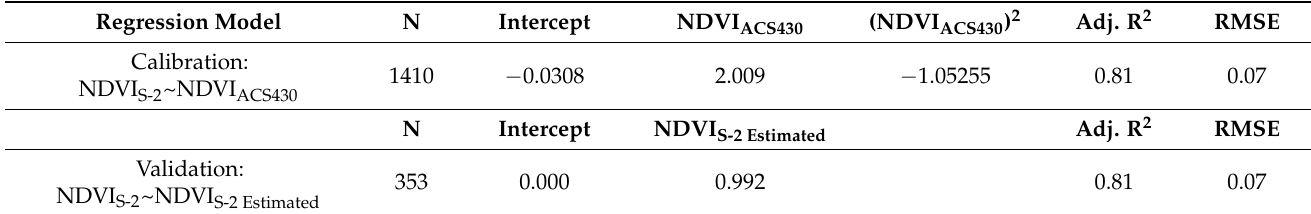
Table 5. Estimating the S-2 NDVI values using active optical measurements 1 .